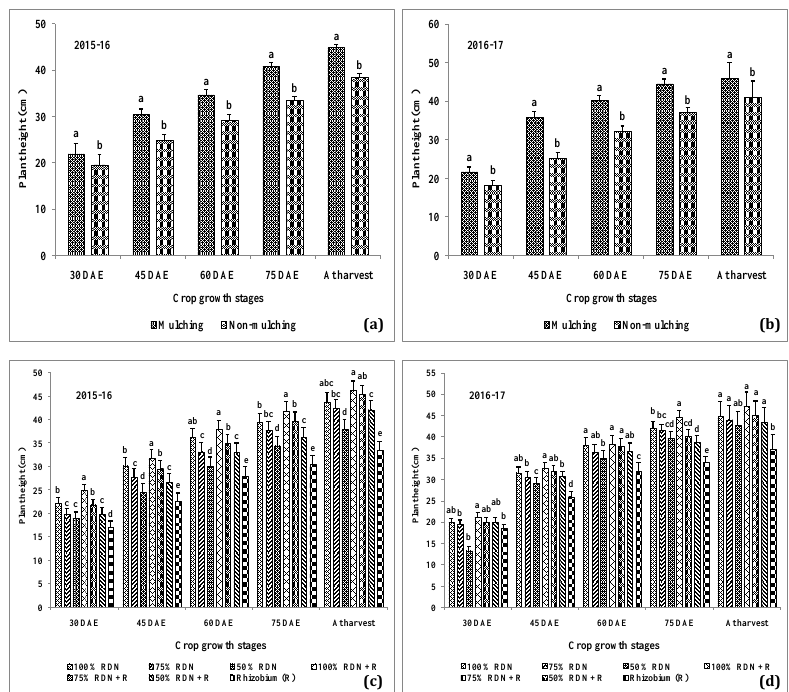
Figure 1. Effect of soil mulch ( a , b ) and nutrient management ( c , d ) on peanut plant height at different growth stages (data from the 2015–2016 and 2016–2017 crop seasons, respectively). DAE—days after emergence; error bars represent the least significant di ff erence values. Di ff erent letters on the bars indicate significant di ff